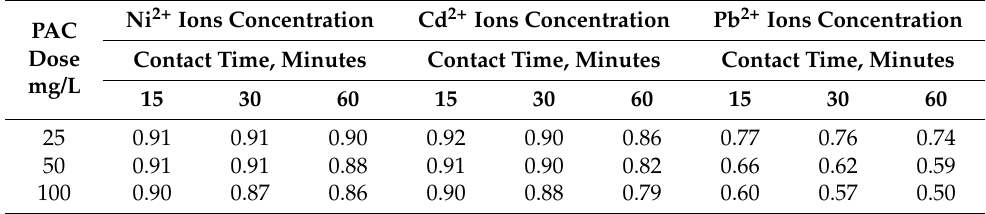
Table 6. Metal ions concentration (mg/L) in model water after adsorption process with PAC, initial metal ions concentration: 1.0